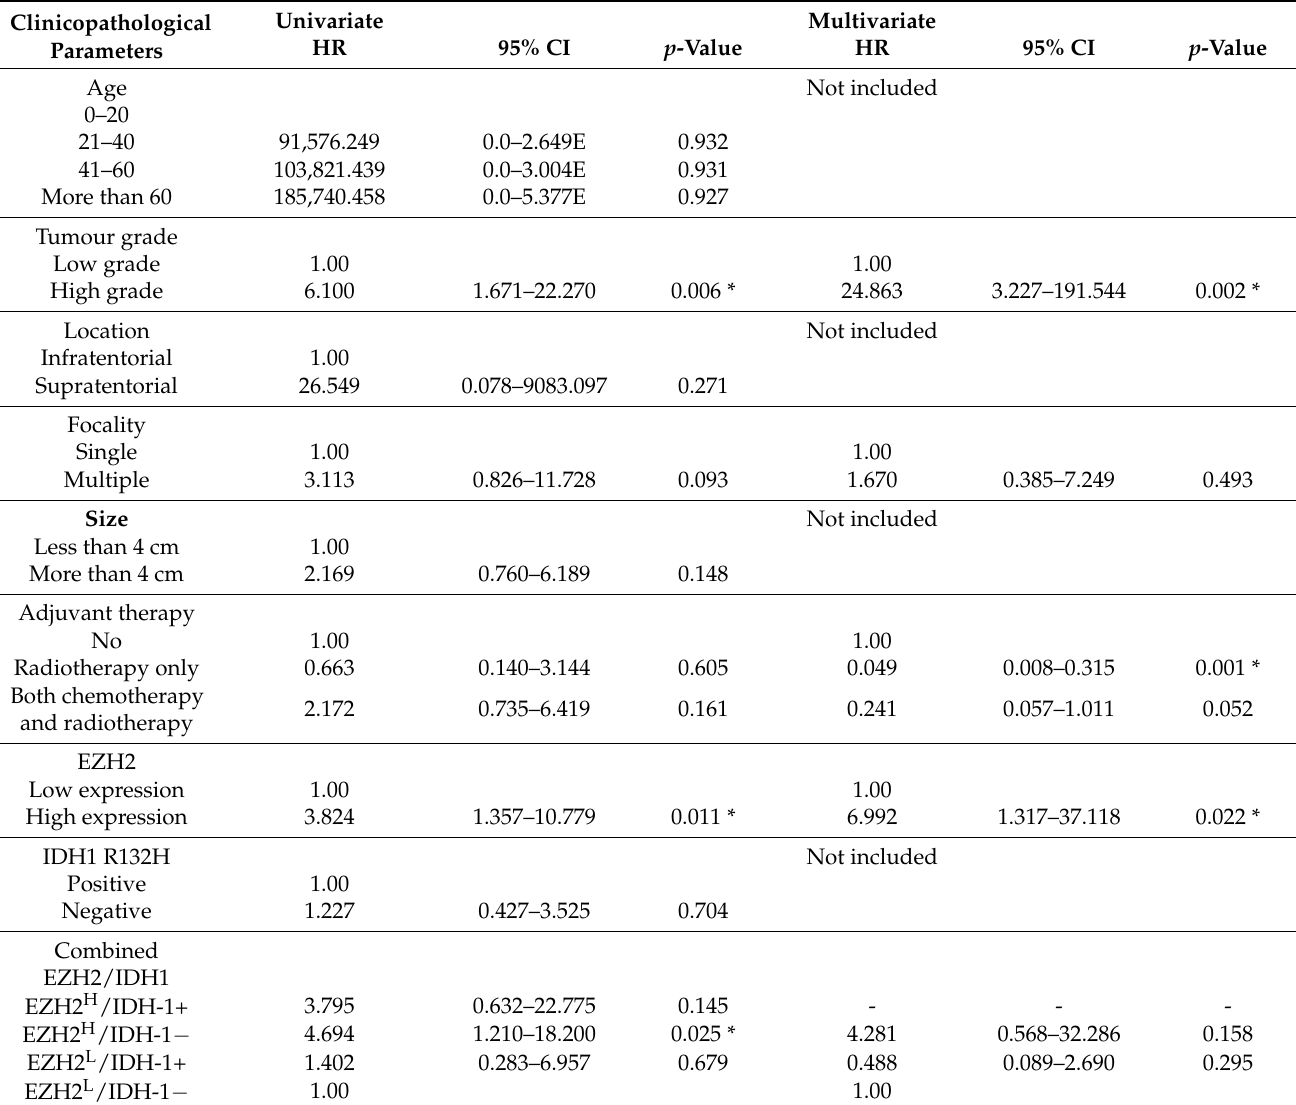
Table 4. Cox regression models for overall survival in patients with